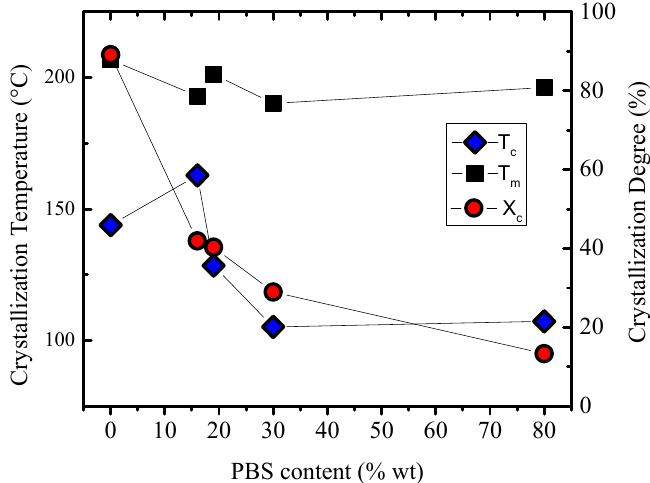
Figure 7. Crystallization degree, crystallization, and melting temperature versus the PBS content for the copolymer/copolymer and copolymer/homopolymer stereocomplexes.